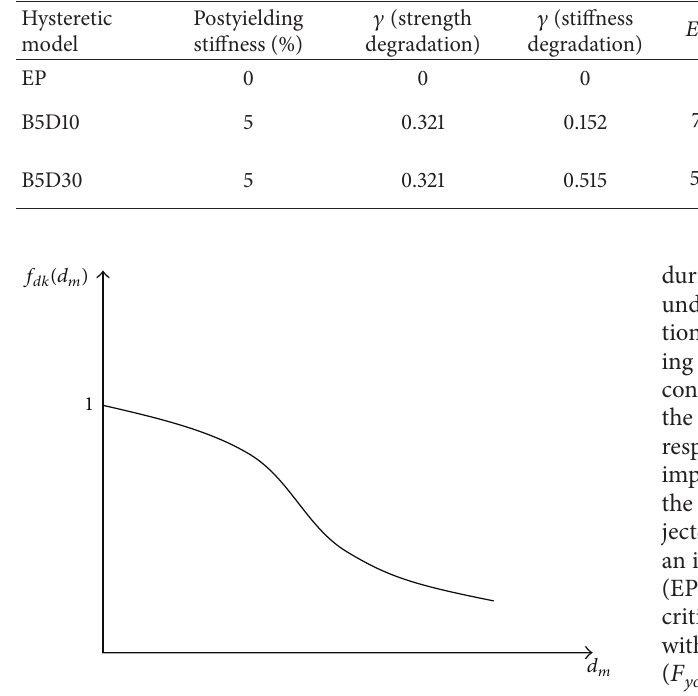
Figure 1: Stiffness degradation function for a system based on maximum displacement